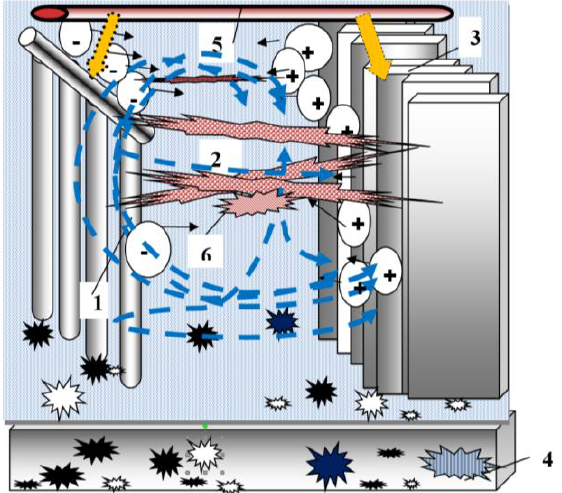
Fig. 3. Structural chart of electric filter in CVFS: 1 – thin wire rods; 2 – is created the electric field between electrodes, connected with the source of high tension; 3 – plates drank for besieging; 4 –container for collection was drunk including; 5 – shaking device; 6 – corona